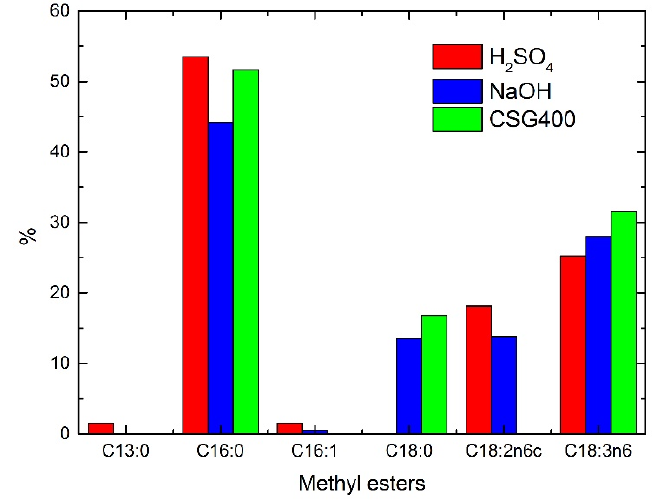
Figure 6. Methyl esters produced by H 2 SO 4 , NaOH, and CSG400.